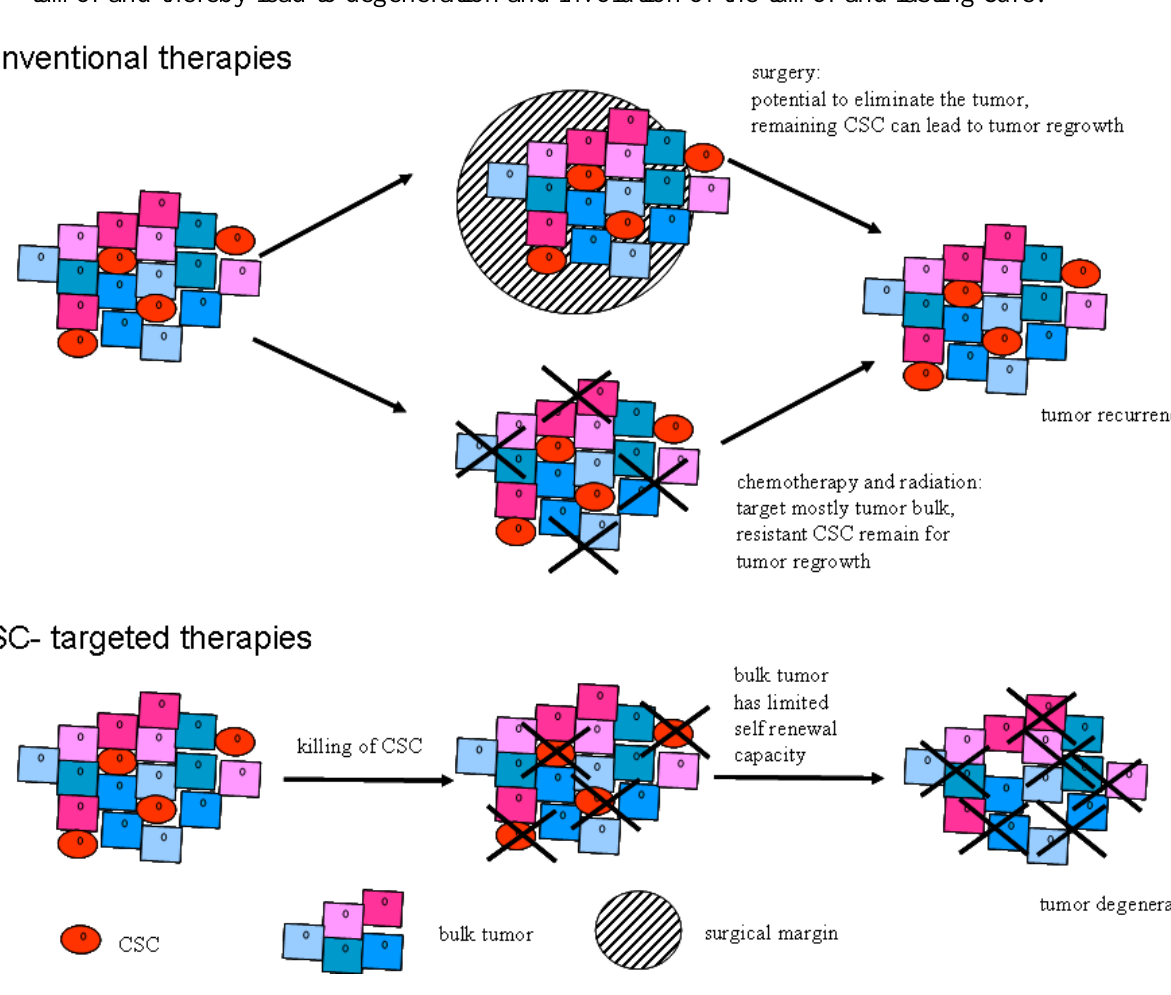
Figure 4. Illustration of therapeutic approaches to tumor elimination. Conventional therapies of solid tumors aim unselectively at removing the bulk tumor mass by surgery with safe surgical margins and, depending on the tumor stage, are often combined with radiation and chemotherapy. Missed CSC due to incomplete removal of the tumor or resistance to treatment will lead to tumor regrowth and ultimately failure of the therapy. Future CSC-targeted therapies may cut off the rejuvenating cell supply by CSC for the tumor and thereby lead to degeneration and involution of the tumor and lasting cure.